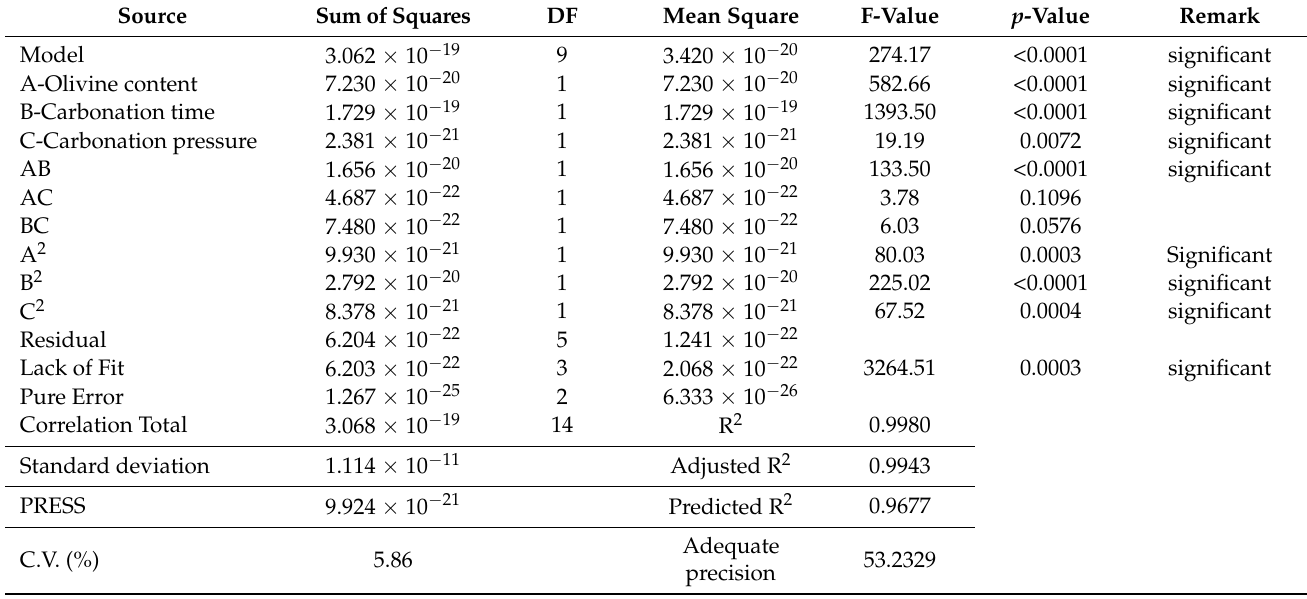
Table 5. ANOVA for response surface quadratic model for hydraulic